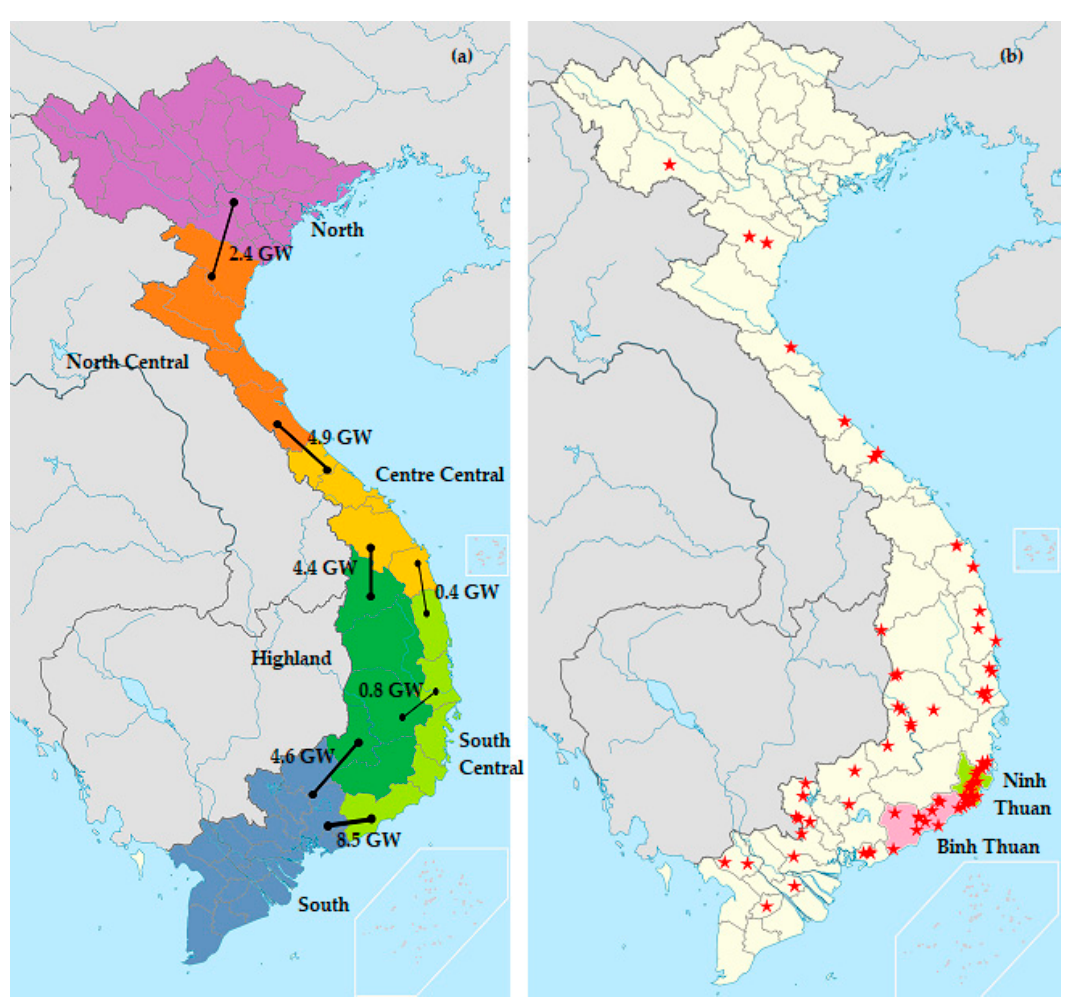
Figure 18. Transmission grid ( a ) and location of approved solar PV plants ( b ) in Vietnam for 2019